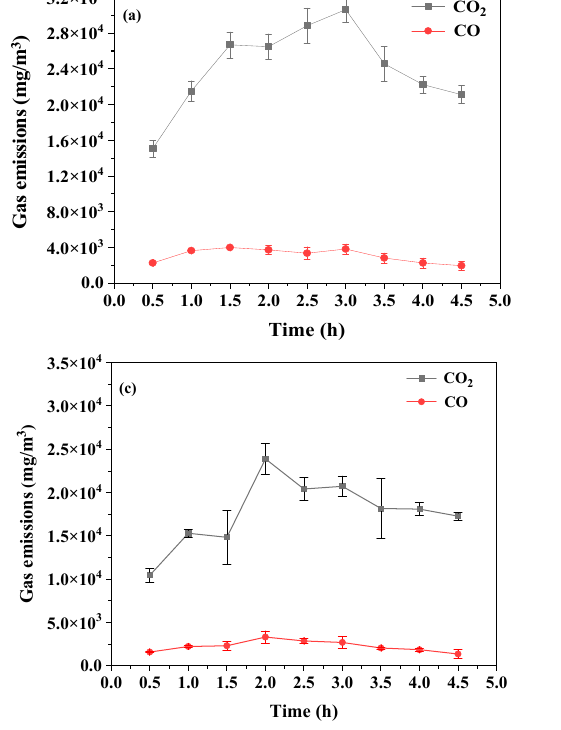
Figure 4. Gas emissions from the smouldering combustion: ( a ) gas emissions at 2% MC; ( b ) gas emissions at 12% MC; ( c ) gas emissions at 22% MC.